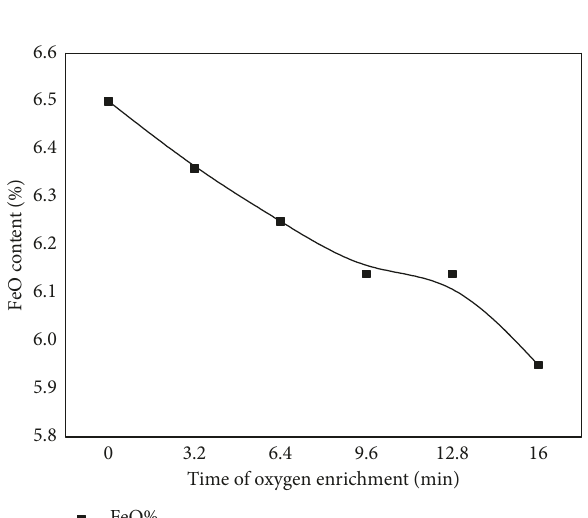
Figure 3: FeO content in the sintered ore for different oxygen enrichment times.